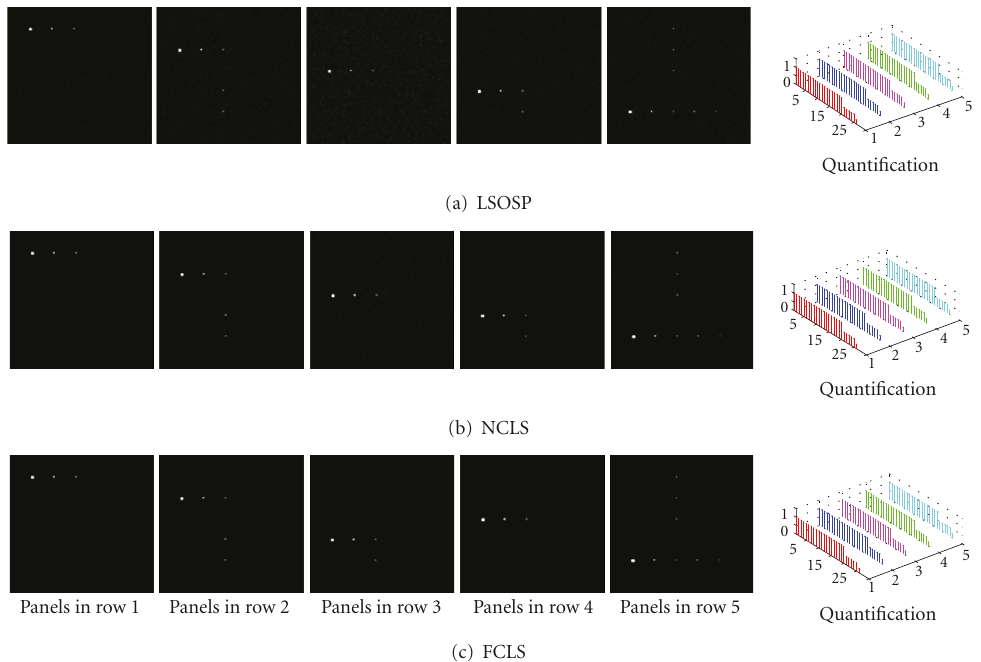
Figure 13: Results using LSOSP, NCLS, and FCLS to unmix TI with assuming signature knowledge in Figure 2.